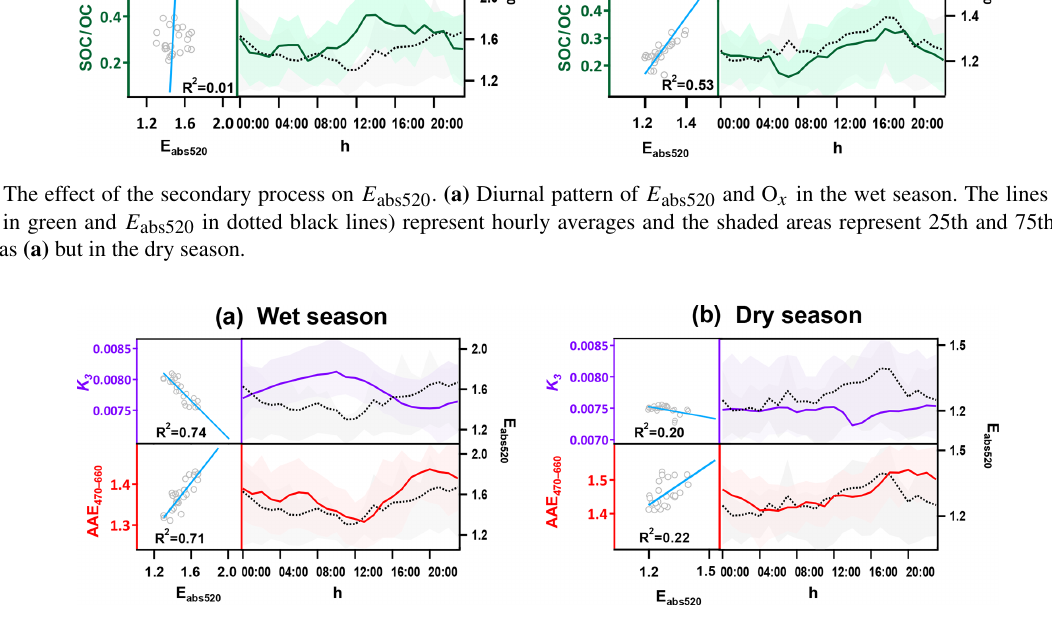
Figure 5. Diurnal patterns of E abs520 , AAE 470–660 and k 3 . The lines ( k 3 in purple, AAE 470–660 in red and E abs520 in dotted black lines) represent hourly averages and the shaded areas represent 25th and 75th percentiles. (a) Wet season. (b) Dry